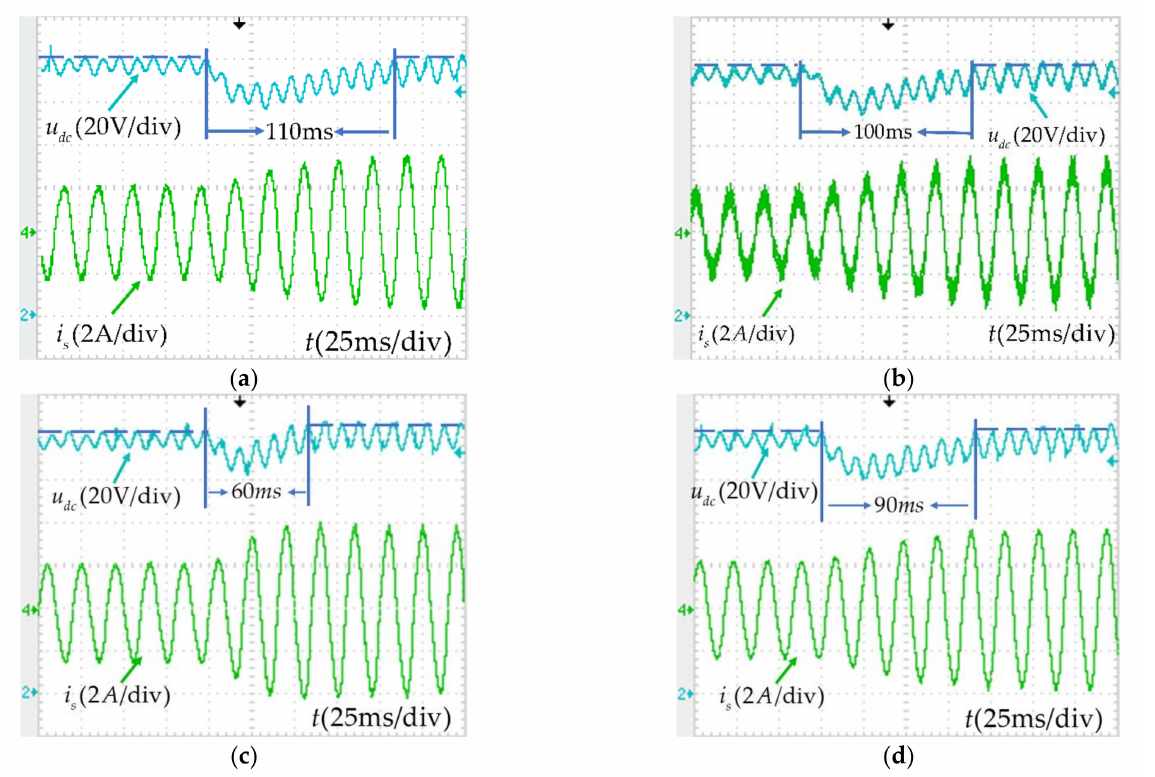
Figure 18. Experimental waveforms of the dynamic response of DC-link voltage. ( a ) PI-ICC; ( b ) FCS-MPC; ( c ) MP-DPC; ( d ) the proposed MPCC.